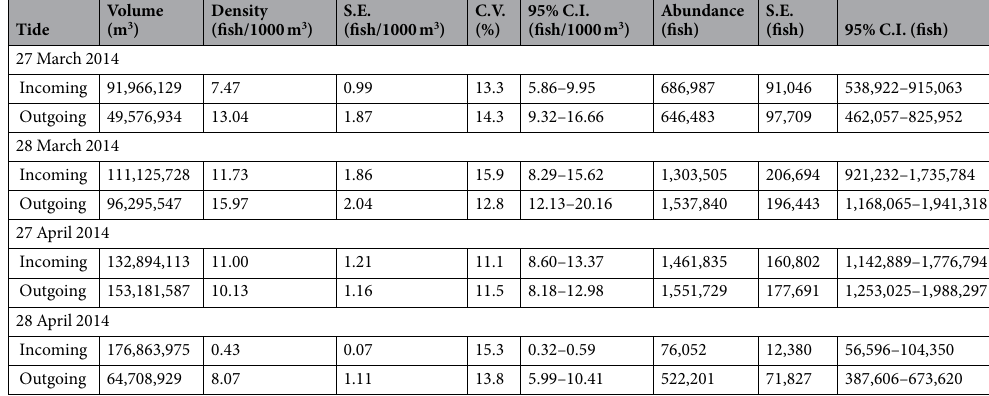
Table 2. Estimates of density and abundance of mature Gulf Corvina ( Cyonscion othonopterus ) per survey. S.E. = standard error; C.V. = coefficient of variation (%); 95% C.I. = 95% confidence interval.